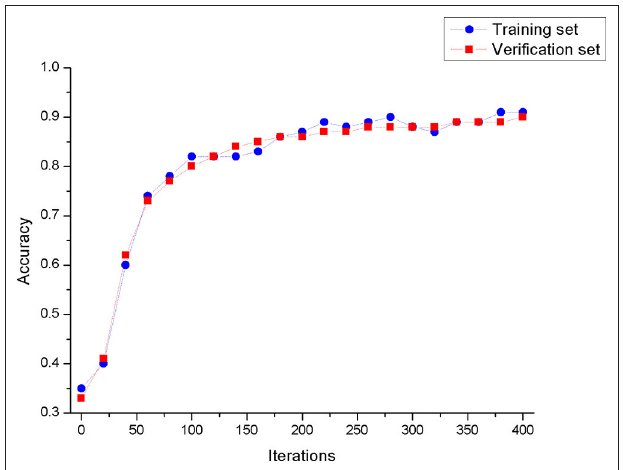
FIGURE 7 | The ErrorBar of accuracy changes with wobble base pairing